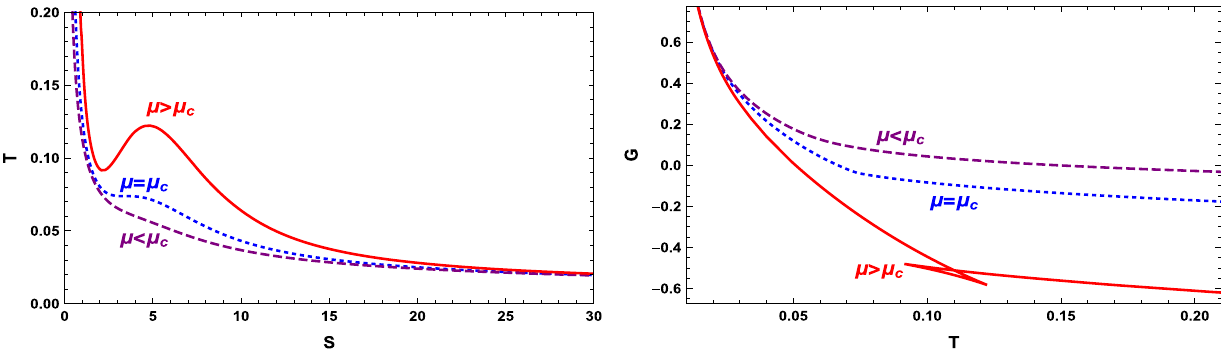
Fig. 8. From the left panel, we see that C (cid:16),μ is negative for